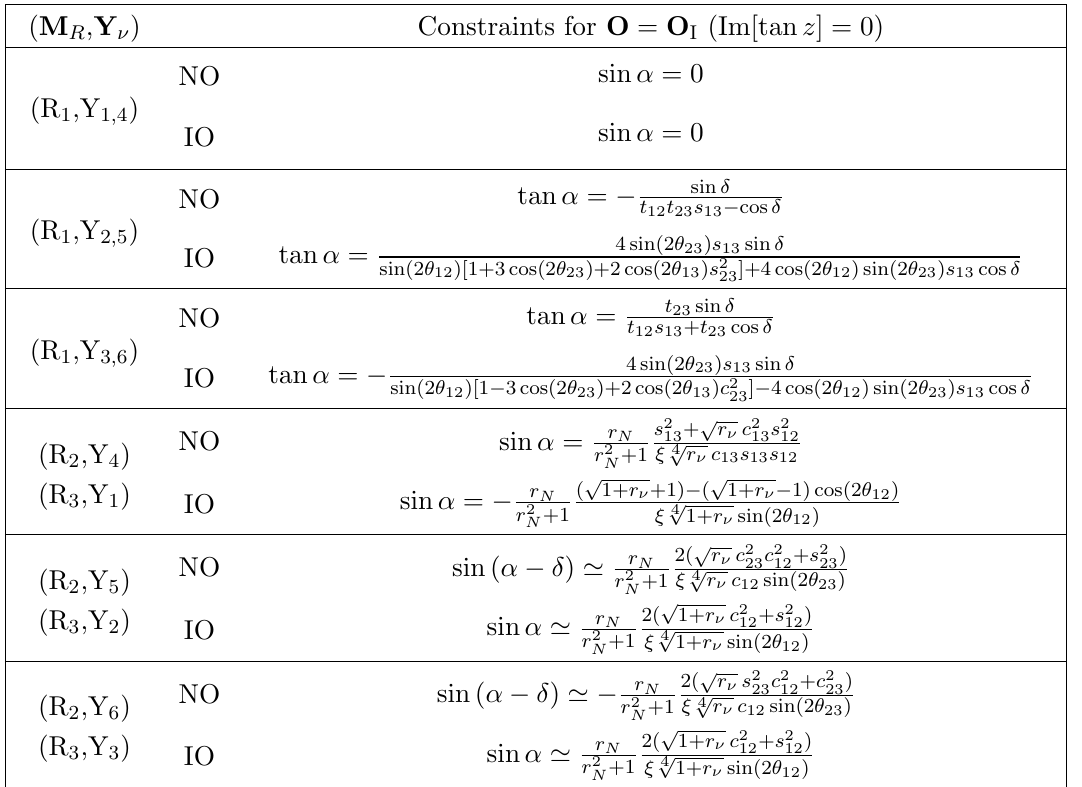
Table 4 . Relations among low-energy parameters obtained in the 2RHNSM with one remnant CP symmetry, for Y (cid:23) and M R of the forms Y 1 (cid:0) 6 and R 1 (cid:0) 3 , respectively. Here, r N 6 = 1 and O = O I . Notice that, since interchanging the second and third lines of Y (cid:23) corresponds to the same operation in U (see eq. (2.11)), the results for Y 3 (Y 6 ) are obtained from those of Y 2 (Y 5 ) performing the transformation (cid:18) 23 ! (cid:18) 23 + (cid:25)= 2. This can be seen by comparing the second (sixth) and third (seventh) rows of the table. These properties are general and, therefore, are also veri(cid:12)ed in table 5. Due to the complexity of the relations for O I , only the zeroth order in s 13 is shown for the results of R 2 ; 3 with the patterns Y 2 ; 3 ; 5 ; 6 .